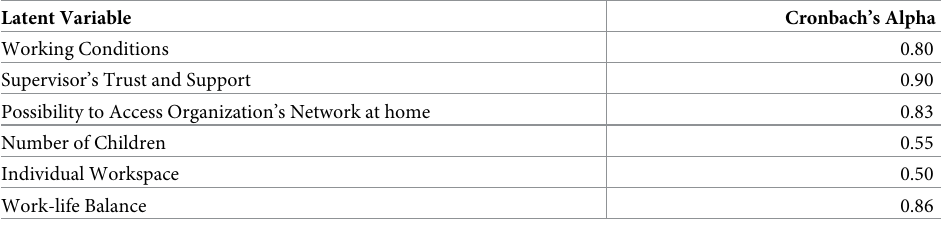
Table 2. Reliability statistics of latent